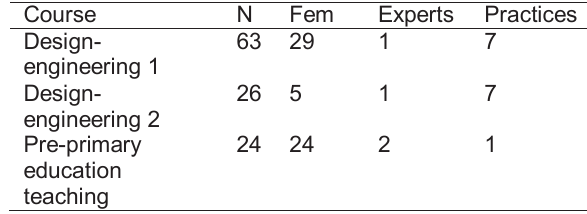
Table 5. Courses of the empirical experience